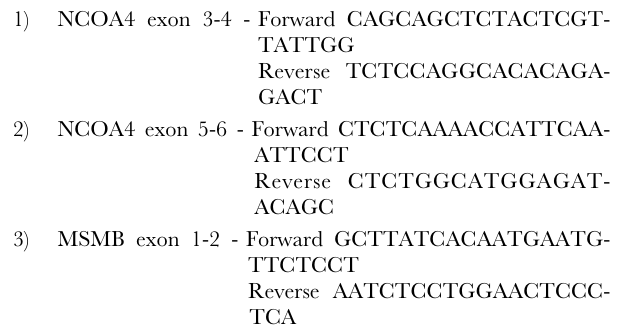
Figure S1 RNA expression of MSMB and NCOA4 in tumor prostate tissue by genotype at rs10994994. Expression in prostate tumor tissue in the Physicians’ Health Study series (n= 59). Each point represents absolute RNA expression for one individual. The top and bottom of the boxes within each graph represent the upper and lower quartiles for expression at each genotype. The band inside each box marks the median value. P-value for association with MSMB expression, 0.0073. P-value for associa- tion with NCOA4 expression, 0.2671.